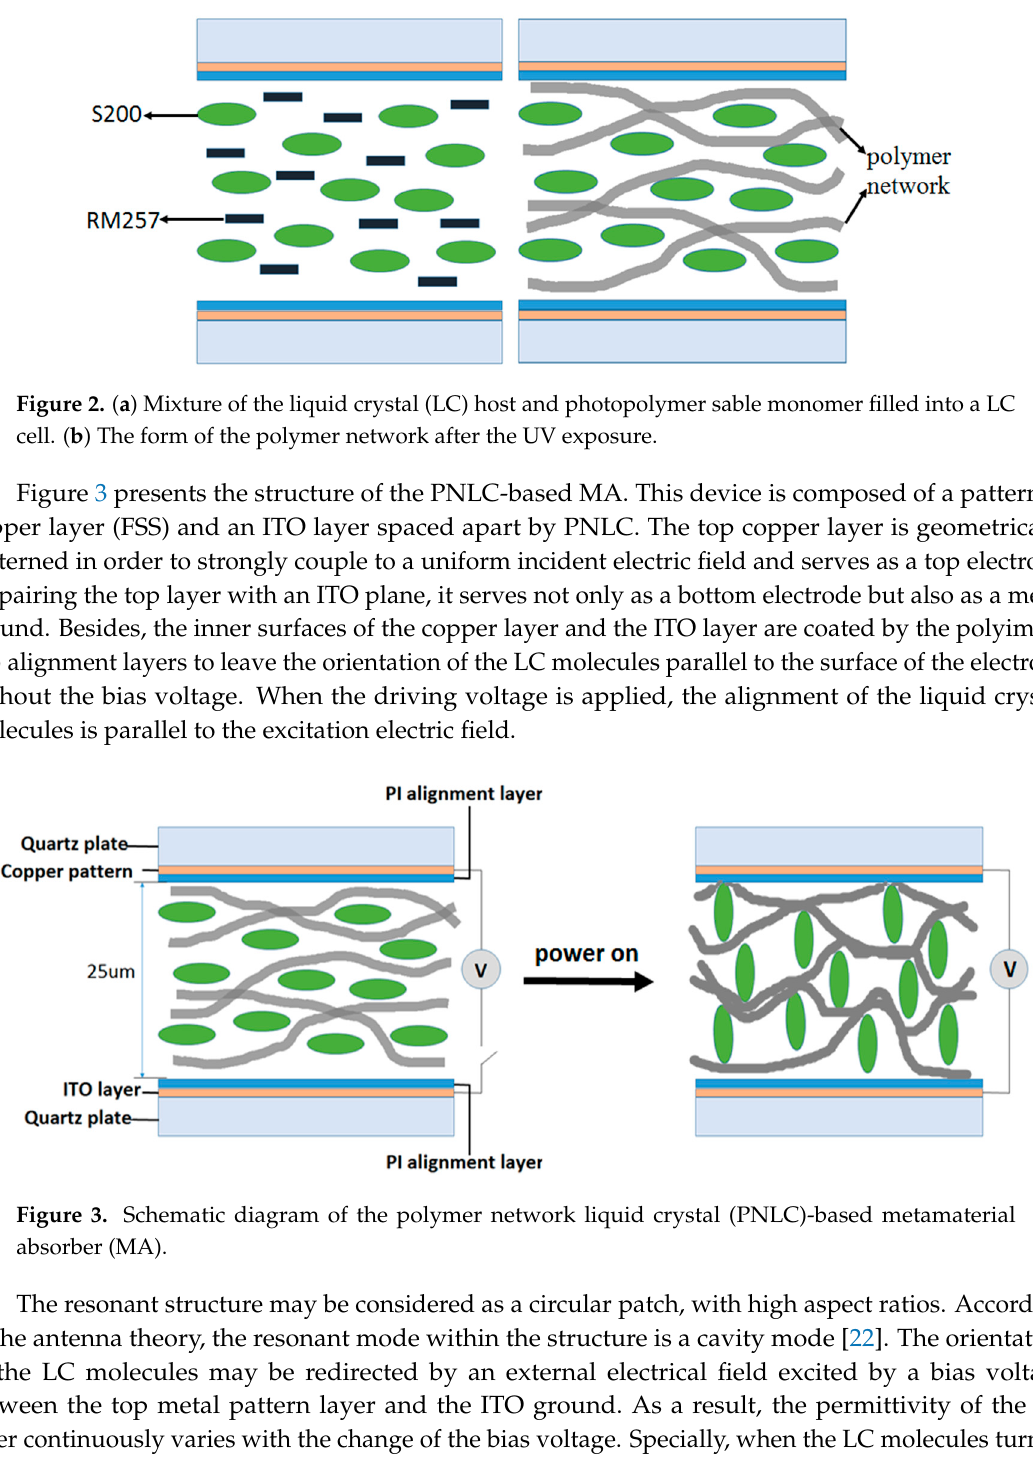
Figure 3. Schematic diagram of the polymer network liquid crystal (PNLC)-based metamaterial absorber (MA).